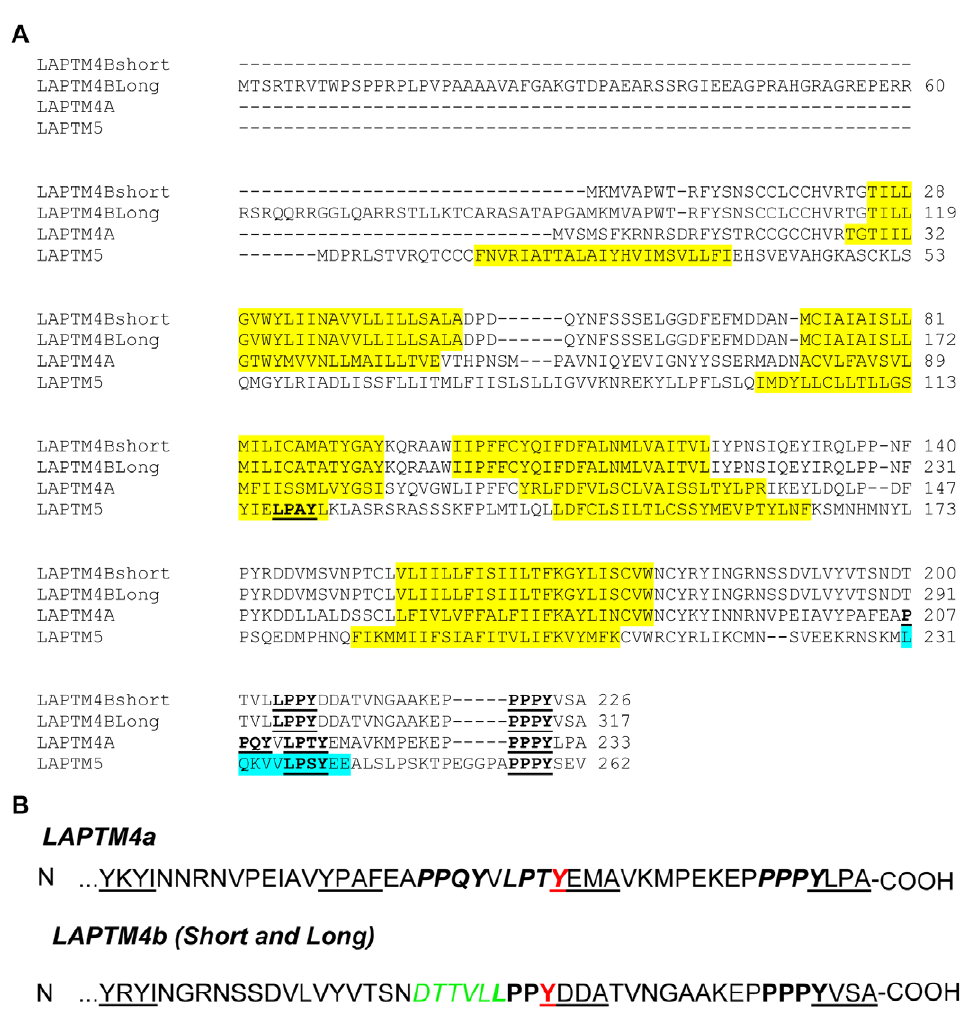
Figure 1. Sequence alignment of the LAPTM family of proteins. (A) ClustalW [49] amino acid sequence alignment of the LAPTM4 family members LAPTM4a (GenBank:AAH03158.1), 24 kDa-LAPTM4b (short) (GenBank: AAH31021.1), 35 kDa-LAPTM4b (long) (NP_060877.3) and LAPTM5 (GenBank: AAI06897.1). Putative transmembrane regions (predicted by SMART [50]) are highlighted in yellow, PY motifs are bold and underlined, and the UIM motif of LAPTM5 highlighted in blue. (B) PY motifs in the C-terminal tails of LAPTM4a and LAPTM4b are indicated in bold. Putative Tyrosine- based motifs are underlined. The dileucine motif is indicated in green ( italicized ), with the bold Leu shared with the PY motif. Tyrosine residues shared by tyrosine-based and PY motifs are indicated in red.